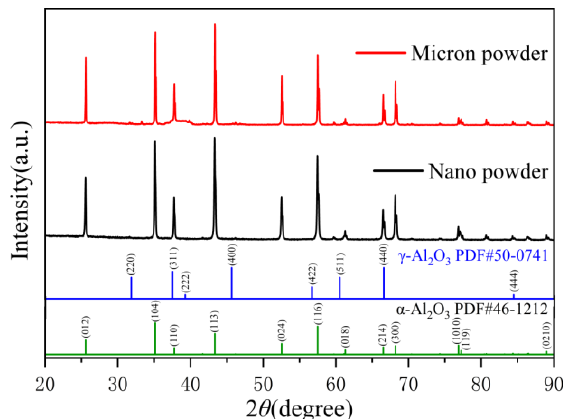
Figure 3. XRD pattern of Al 2 O 3 powder.